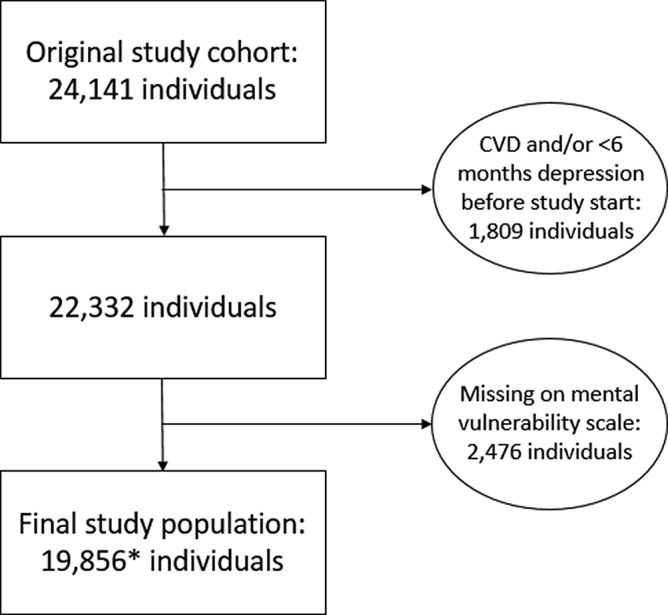
Flow chart of selection of study population. Footnote: 620 individuals included into the study again at the time of a cardiovascular disease (CVD) after depression.